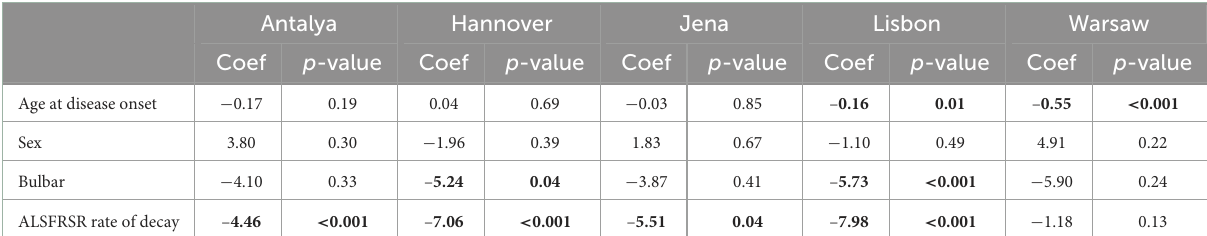
TABLE 2 Multivariate linear regression analysis assessing predictors of diagnostic delay in ALS patients from each European center. Antalya Hannover Jena